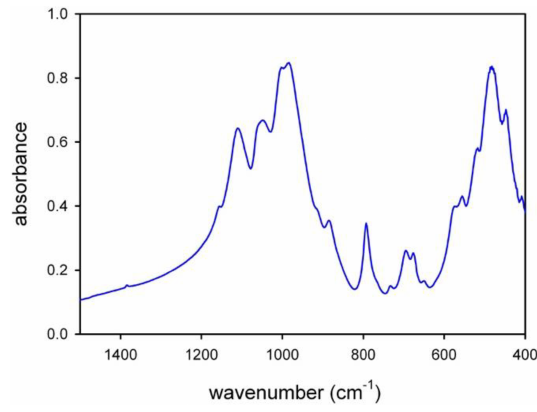
Figure 5. Powder FTIR spectrum of the studied glaucophane in the low-frequency lattice-mode